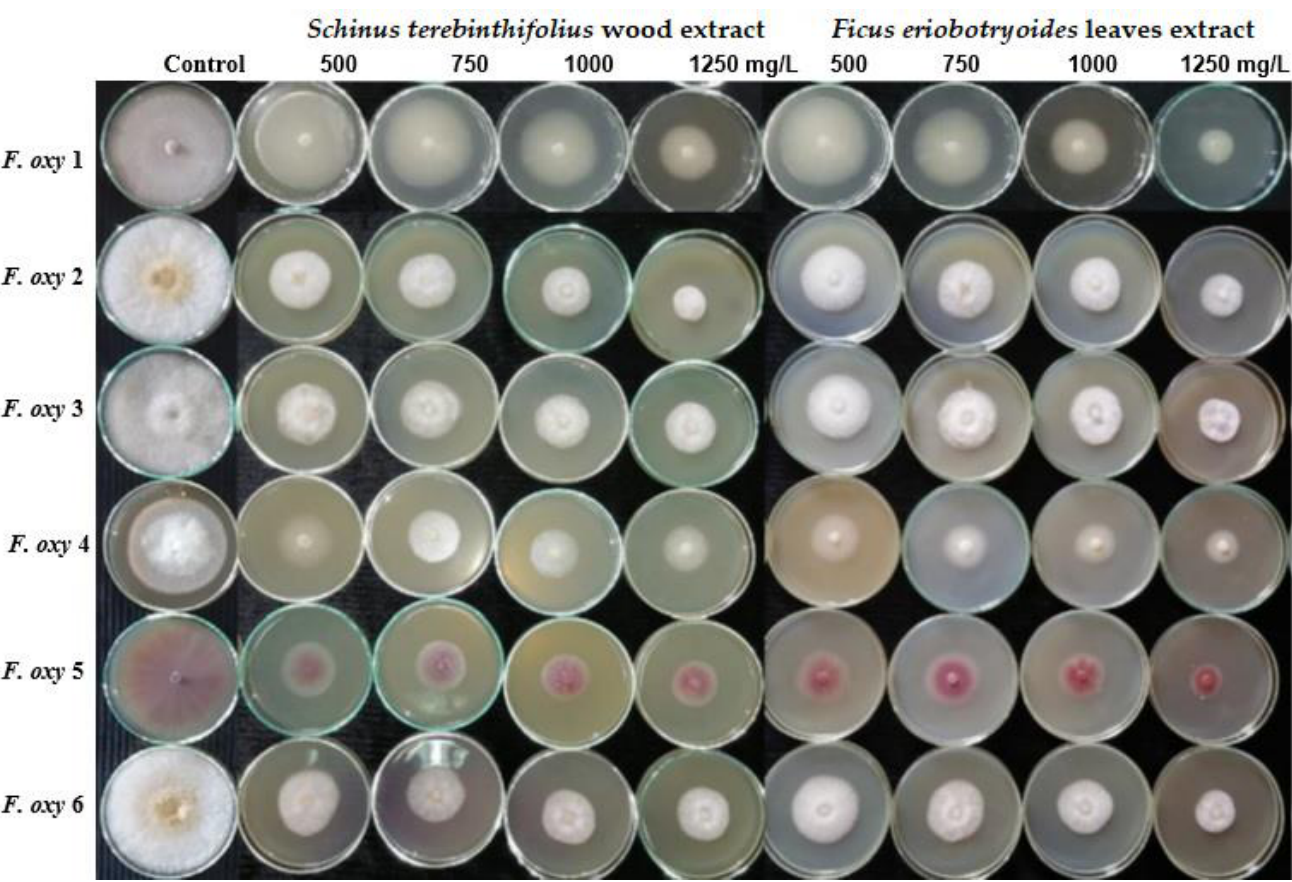
Figure 2. Visual observations of the antifungal activity of extracts from Conium maculatum leaves, Acacia saligna bark, Schinus terebinthifolius wood and Ficus eriobotryoides leaves against six isolates of F. oxysporum .